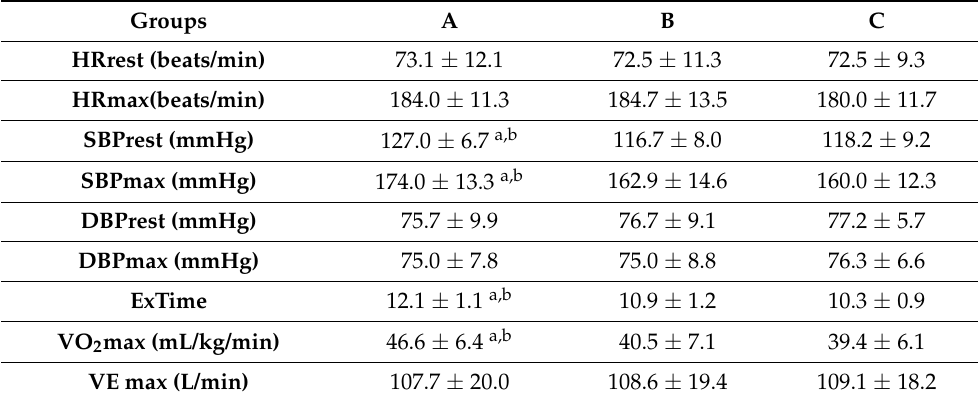
Table 2. Results from the cardiopulmonary exercise testing (mean ±